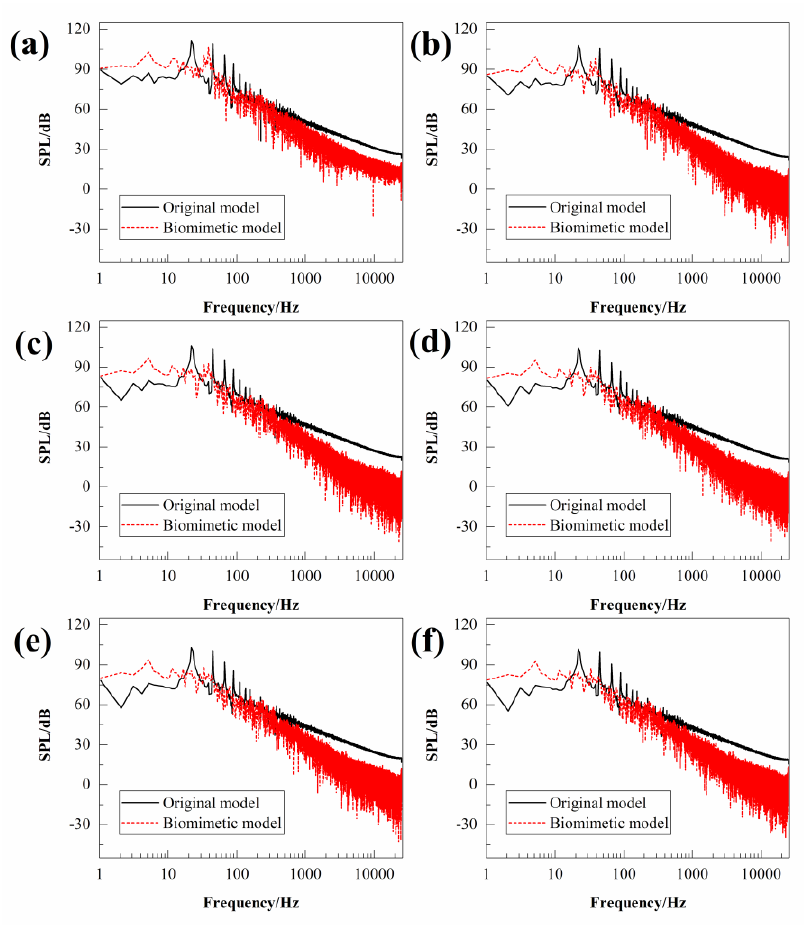
Figure 17. Comparison of the predicted SPL spectra of the original hydrofoil and biomimetic hydrofoil at the six observing points in the radial direction of the near sound field: ( a ) p 17 ; ( b ) p 18 ; ( c ) p 19 ; ( d ) p 20 ; ( e ) p 21 ; and ( f ) p 22 .